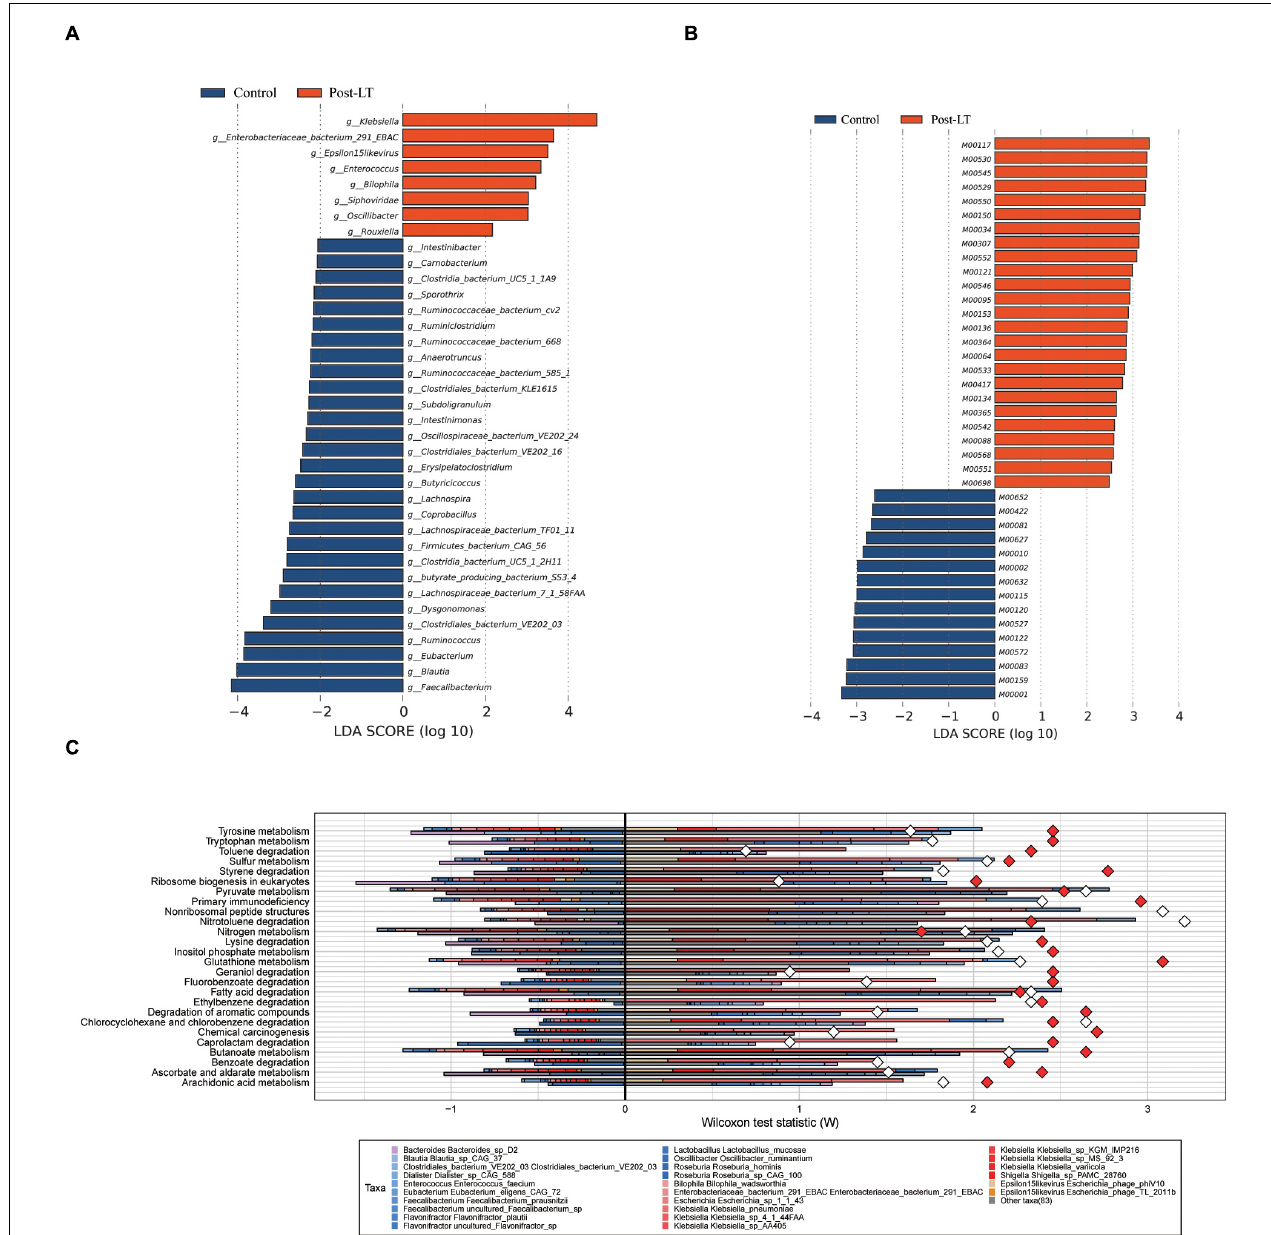
FIGURE 5 | (A) LEfSe analysis of gut microbiota composition between post-LT and control groups. (B) LEfSe analysis of functional profiles between the two groups. Histogram of the LDA scores calculated for a differential abundance of genera in the two groups. Different colors represent different groups. (C) Fishtaco analysis of species contribution to metabolic pathways between the post-LT and control groups. The x -axis represents the Wilcoxon test statistic scores, and the y -axis the related functions. The driving factors for each differential function transformation were divided into four parts, represented by a histogram in two directions. Gut microbiota in the post-LT group that drove the increase in the corresponding functional abundance (top right); Gut microbiota in the post-LT group that inhibited the increase in the corresponding functional abundance (top left); Gut microbiota in the control group that drove the increase in the corresponding functional abundance (bottom right); and gut microbiota in the control group that inhibited the increase in the corresponding functional abundance (bottom left). Different color bars represent the corresponding species. The longer the bar, the greater the driving or inhibiting effect of the species on the corresponding